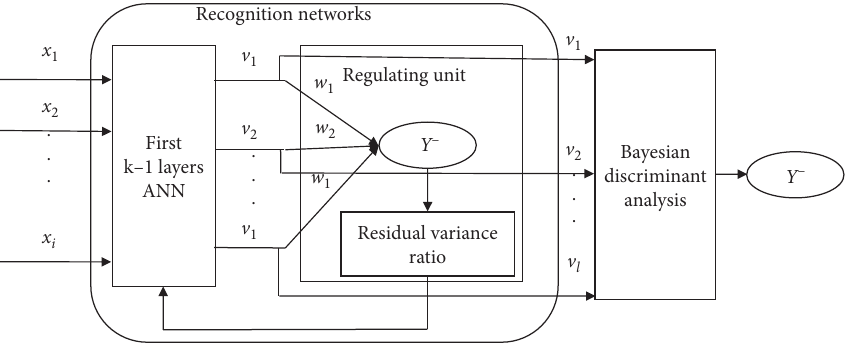
Figure 1: Forecasting method.